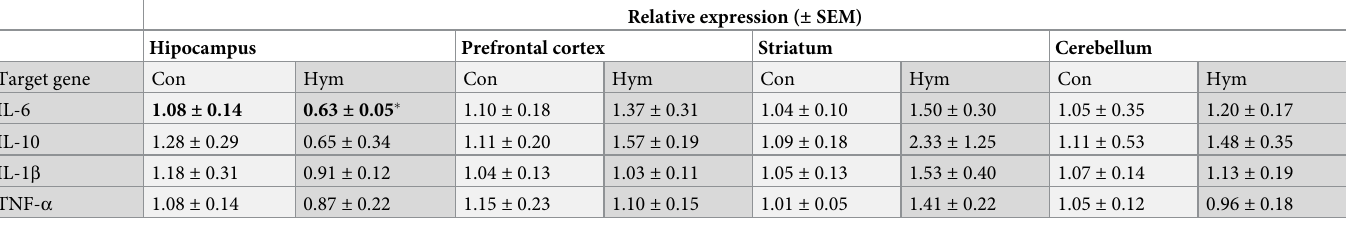
Table 3. Real-time quantitative RT-PCR analyses for control rats (Con, n = 8) and rats infected with H . diminuta (Hym, n = 7). Gene expression levels represent the mRNA expression for IL-6, IL-10, IL-1 β and TNF- α in the hippocampus, prefrontal cortex, striatum and the cerebellum levels relative to the control. Values represent the means ± SEM for two experimental